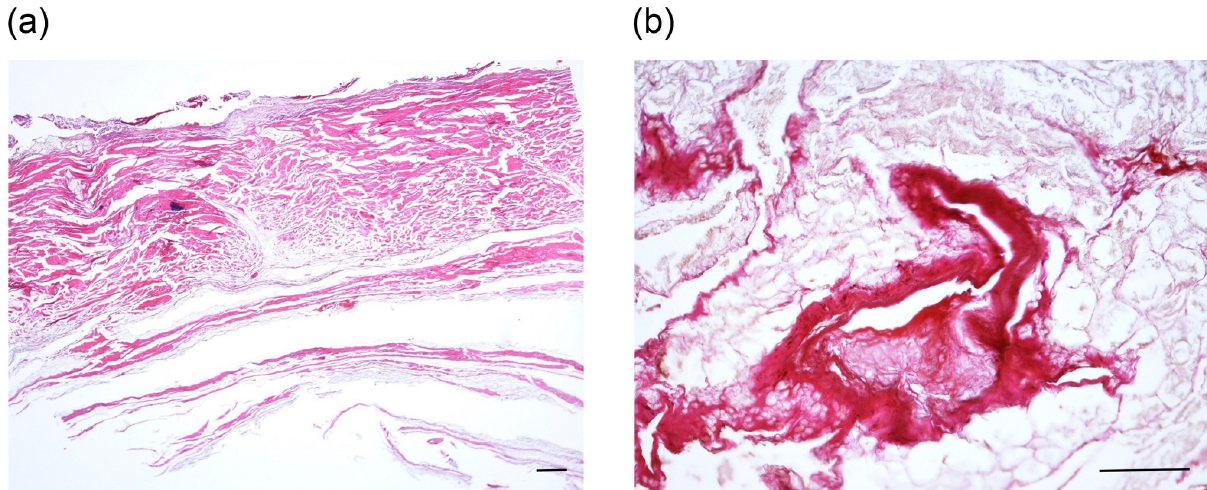
Fig 13. A. Histological section through the mummy’s skin. Despite the loss of the superficial epidermis the collagen matrix of the dermis is excellently preserved. (H&E); bar = 1.000 μ m. B. Histological view of a small arteriole of the subcutaneous skin tissue of the mummy. Again, very well-preserved structures are present. There is no evidence for vascular narrowing (microangiopathy) (Elastica-van Gieson stain); bar = 200 μ m.